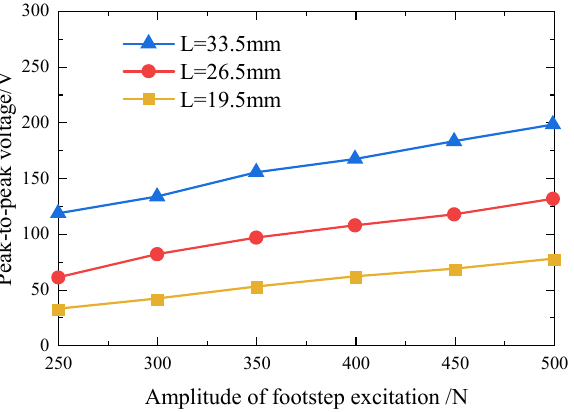
Figure 8. Peak-to-peak voltages from 1#1 PZT4 patch on unimorph PCS of 1# piezoelectric brick versus the amplitude of footstep excitation ( f = 1 Hz). ( it is modified) Table 2. Peak-to-peak voltages (V) from 1#1 and 2#1 PZT4 patches ( f =1 Hz).